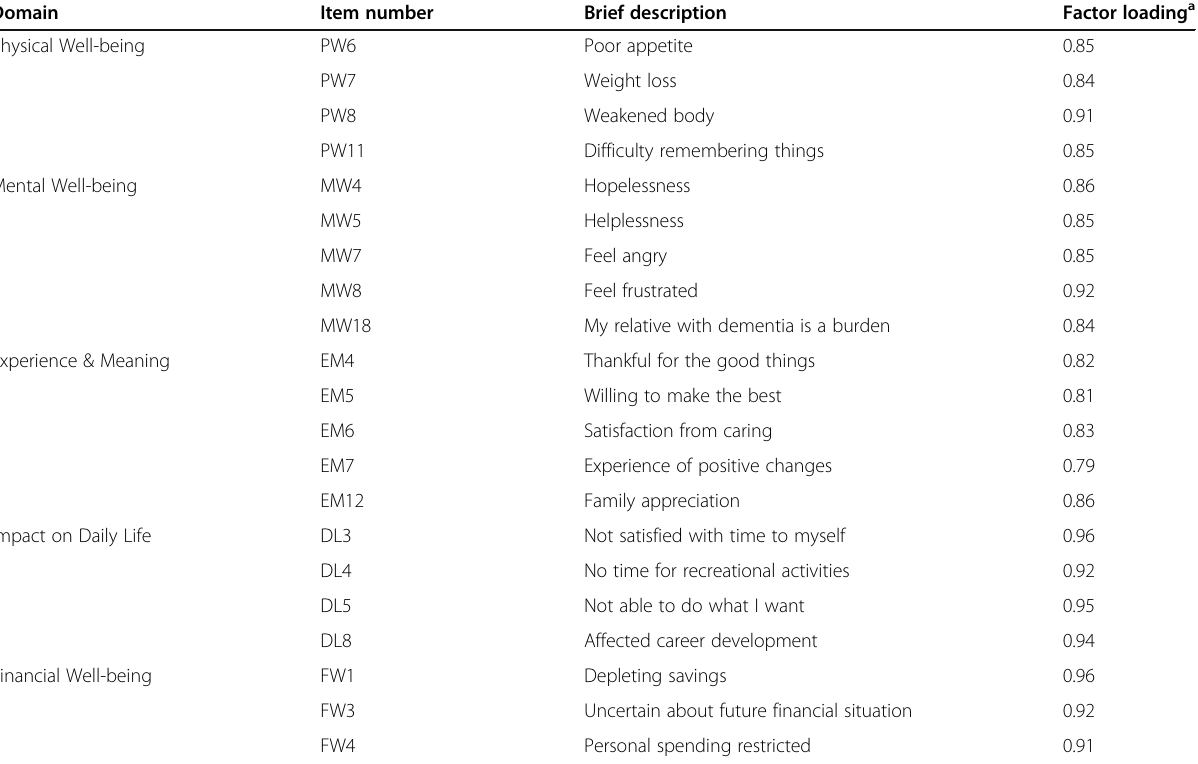
Table 1 Candidate items for short form identified from exploratory factor analysis of the Singapore Caregiver Quality of Life Scale – Dementia (SCQOLS-D)